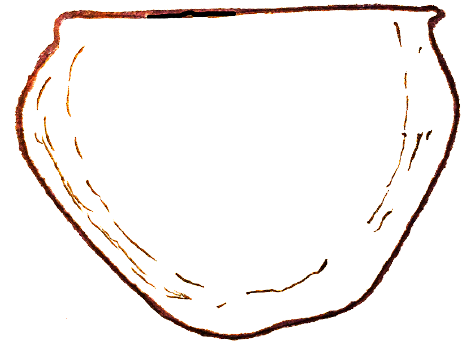
Figure 9. Bradoria sp. Anterior to left. Length of shield 1.28 mm. Image Credit: Mark McMenamin.